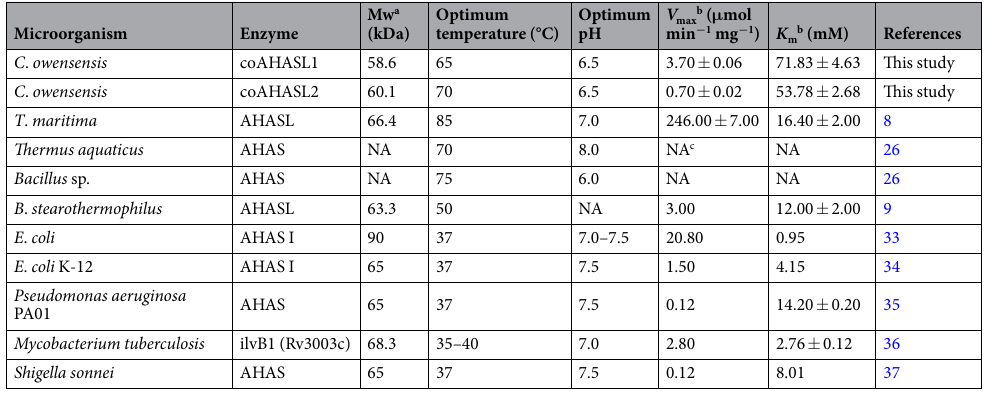
Table 1. Comparisons of the catalytic subunit of AHAS with pyruvate as a substrate. a MW, molecular weight by SDS-PAGE. b The activity of each enzyme was determined under the optimal conditions with pyruvate as a substrate. c NA, not available. ± indicates the standard deviation of three independent